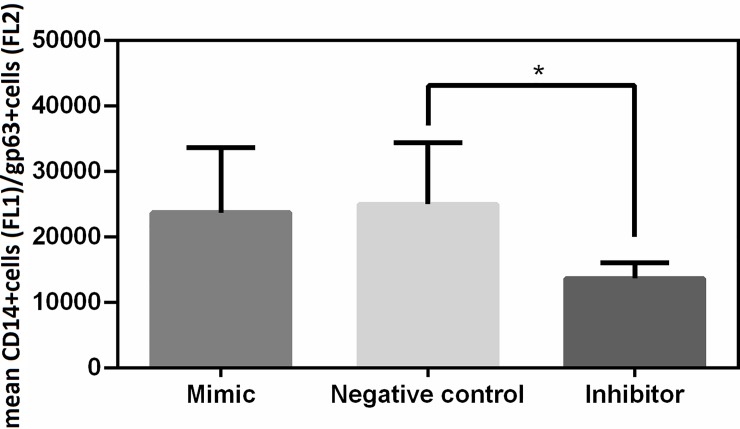
Parasite load.Parasite load in cultures of SL naturally infected by L. infantum and transfected with negative control (scrambled), miR 21 mimic, miR 21 inhibitor for 67h. Data represent mean + standard error of the mean. Asterisks represent significance (p<0.05) by Friedman Test with multiple comparison.